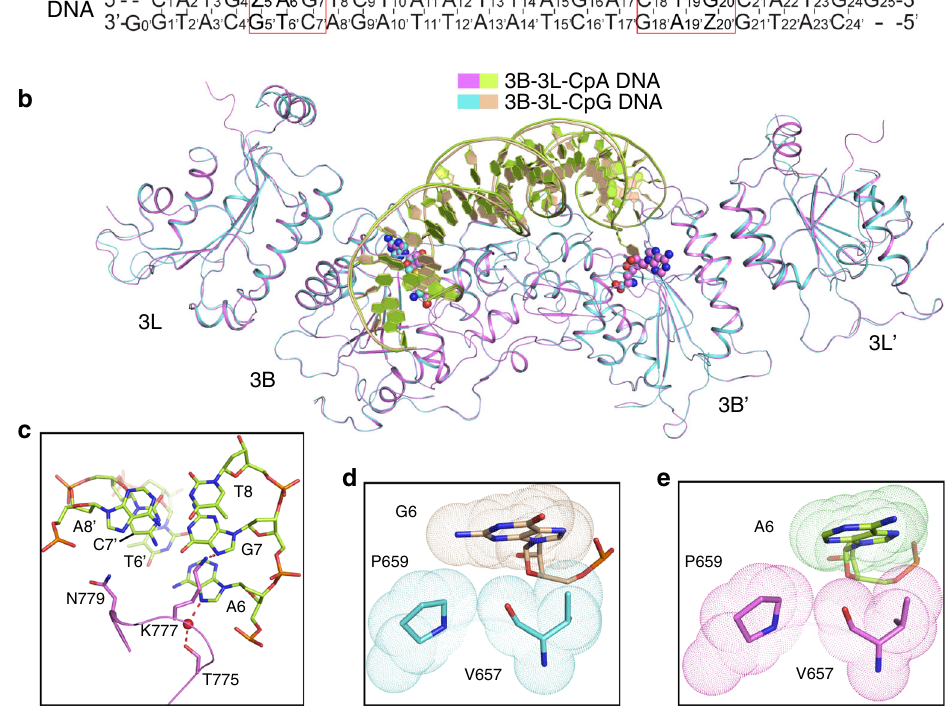
Fig. 5 Structure of the DNMT3B – DNMT3L tetramer in complex with CAG DNA. a DNA sequence used for the structural study. b Structural overlay of the DNMT3B – CAG DNA and DNMT3B – CGA DNA complexes. c Close-up view of the interactions between the TRD loop of DNMT3B and the CAG DNA. d , e Close-up view of the van der Waals contacts between the catalytic loop of DNMT3B and G6 in the ZpG site of the CGA complex d or A6 in the ZpA site of the CAG complex e